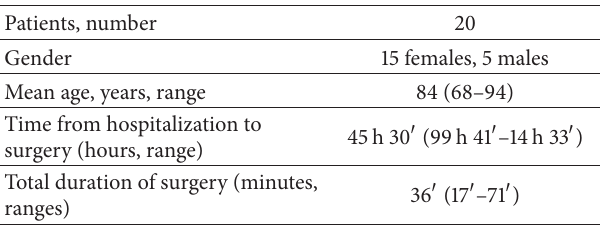
Table 1: Clinical features of the studied patients. Table 2: The data of the cytokines TNF- 𝛼 and IL-6 and of the markers CRP and CK obtained from serum or plasma samples collected 1 hour before and 24 hours after surgery. 𝑝 < 0.05 was considered significant.